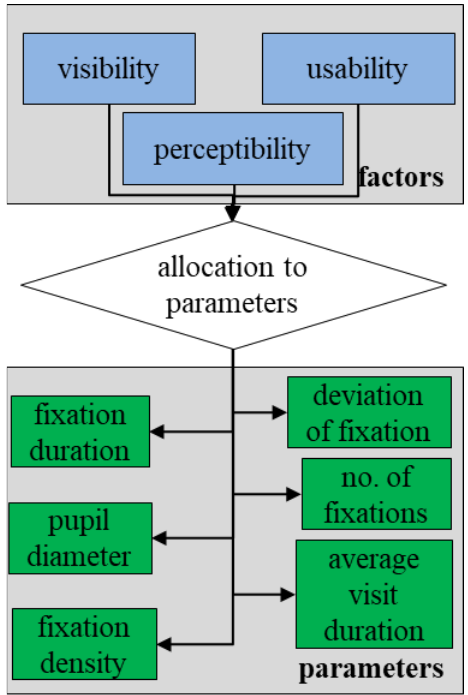
Figure 4. Eye tracking parameters that can be used to determine factors relevant for HMI